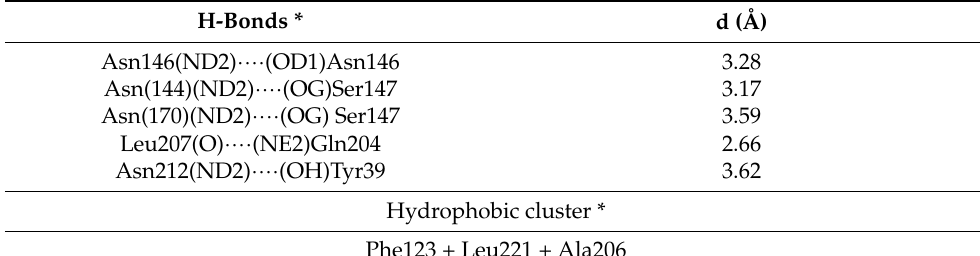
Table 2. H-bonds and hydrophobic interactions at the E-F dimer interface.